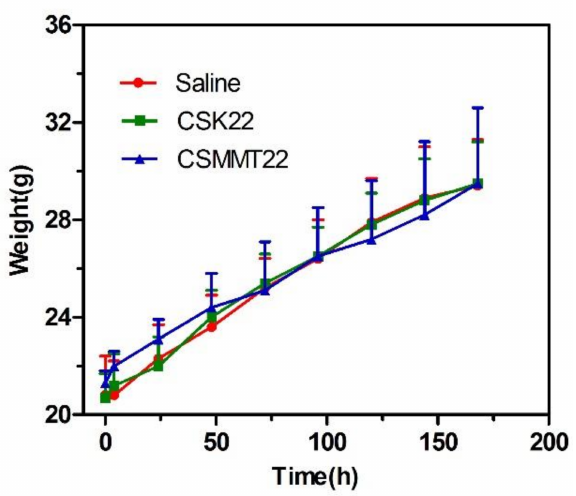
Figure 11. Acute toxicity test results of saline, CSK22, and CSMMT22. Data represent the mean ± SD ( n =